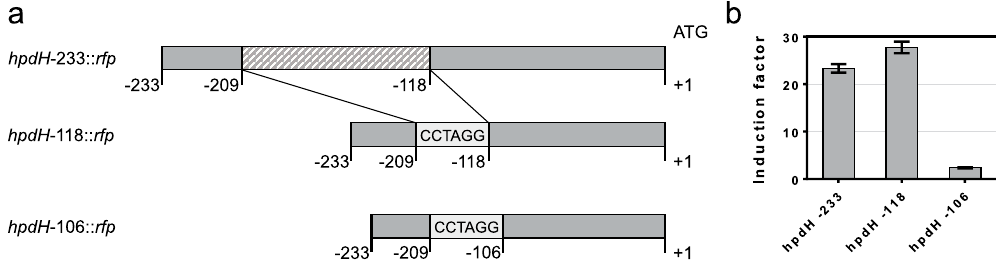
Figure 2. P. putida KT2440 hpdH promoter truncations. ( a ) Schematic illustration of the different hpdH promoter truncations that were evaluated for 3-HP-responsive activation of rfp reporter gene expression. The native promoter-reporter gene construct is denoted hpdH -233:: rfp . The bioinformatically identified palindromic sequence is illustrated as a dashed box. This sequence was replaced by an AvrII restriction site, CCTAGG, resulting in promoter truncations hpdH -118:: rfp and hpdH -106:: rfp . ( b ) Induction levels mediated by the different promoter truncations. The various promoter-reporter gene constructs were analysed in E. coli MG1655 for RFP expression in the absence or presence of 10 mM 3-HP. Error bars represent standard deviations of three biological replicates.